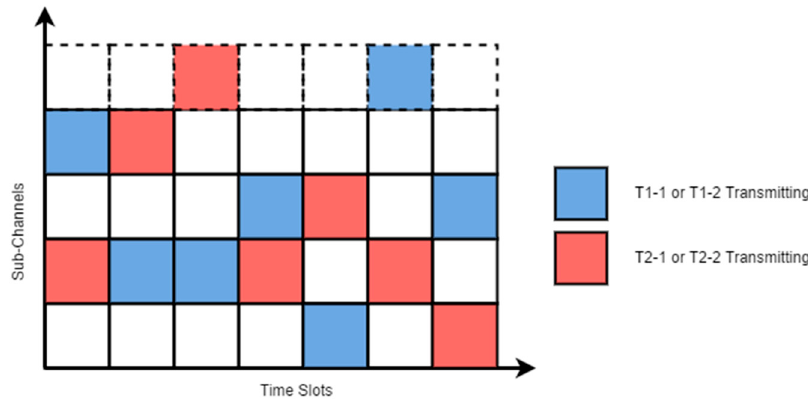
Figure 7. Frequency hopping of telemetries.